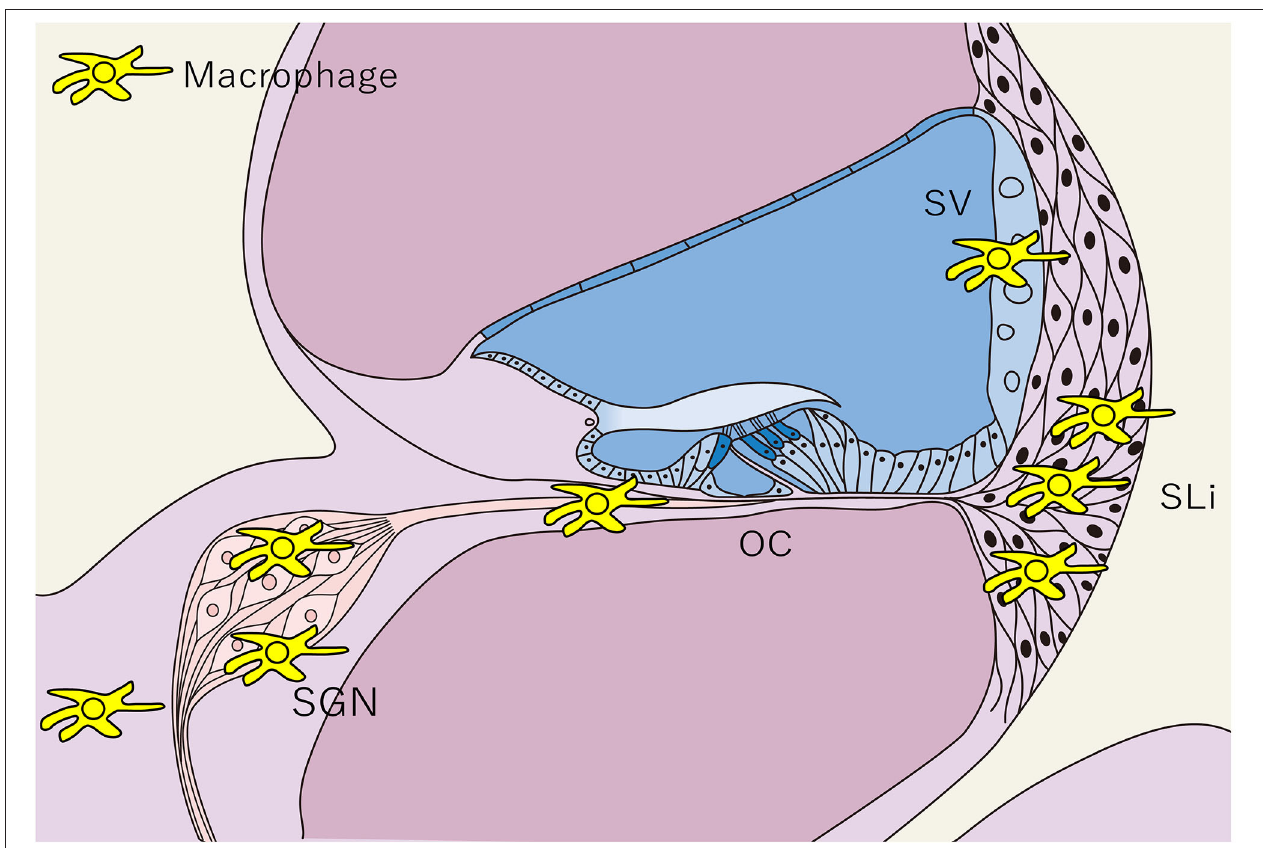
FIGURE 3 | Distribution of tissue macrophages in the cochlea. The distribution of tissue M ϕ s is shown in a schematic cross-sectional view of the cochlea. Tissue M ϕ are distributed in the SGN, SLi, SV, and cochlear modiolus. Cochlear M ϕ s also exhibit spindle-shaped cell bodies and dendritic cell processes under steady-state conditions, as observed in microglia in the central nervous system. SGN, spiral ganglion neurons; SLi, spiral ligament; SV, stria vascularis; OC, Organ of Corti; M ϕ ,